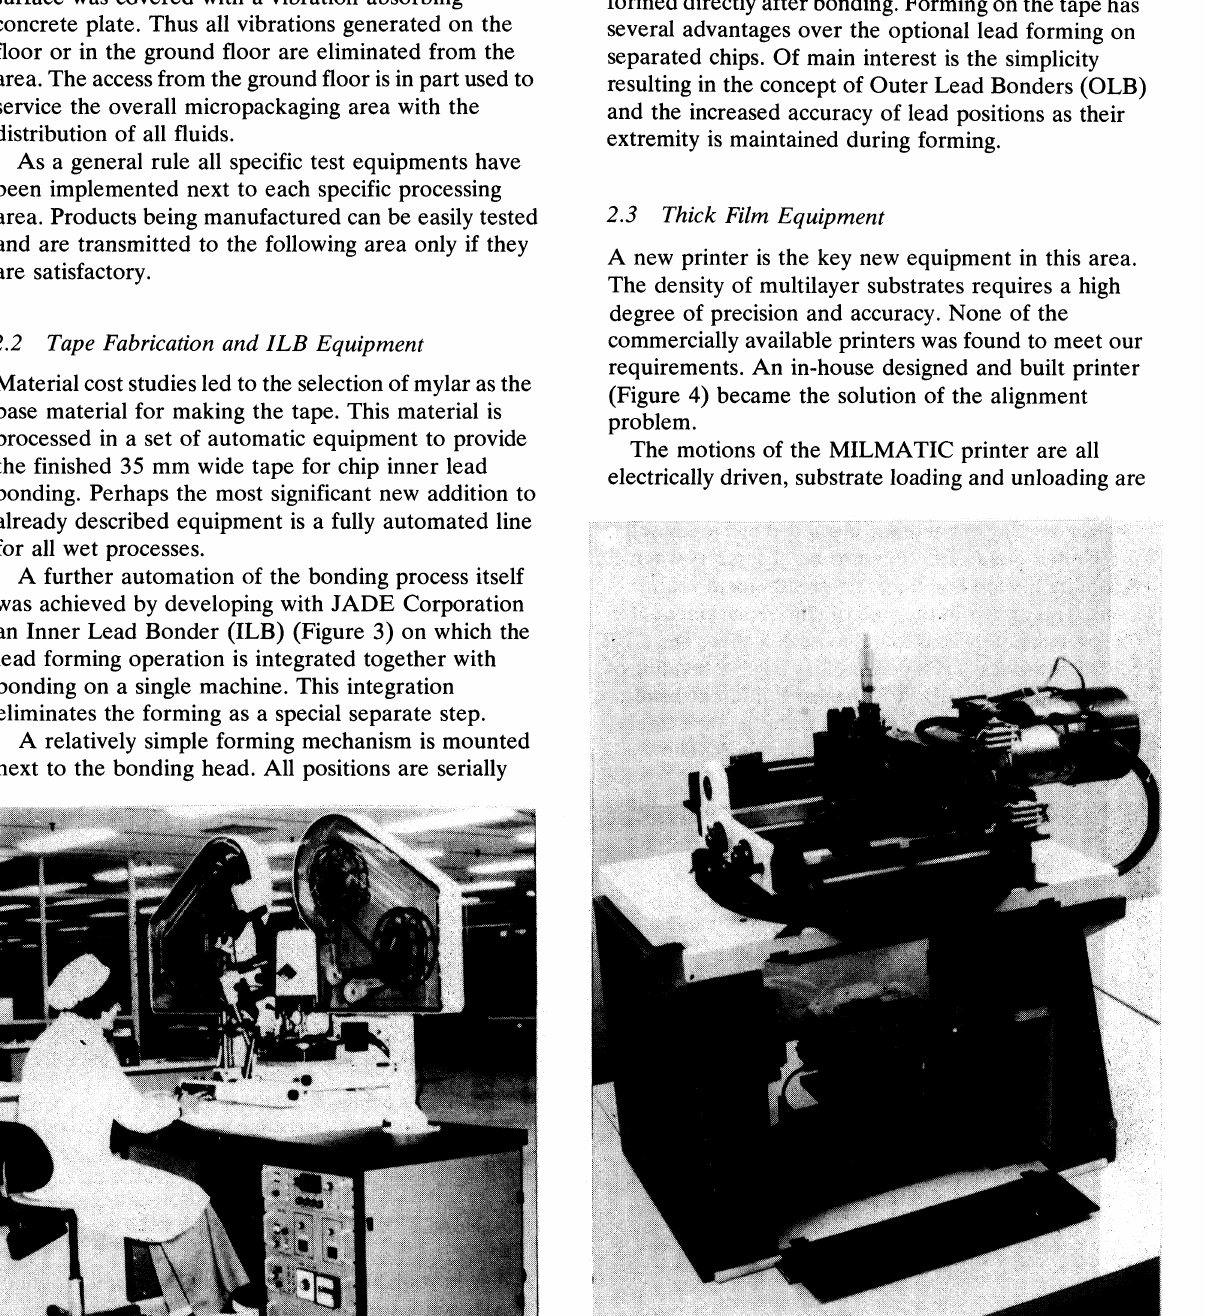
FIGURE 4 MILMATIC high precision thick film printer. The machine designed and built by CII-HB is specially tailored for dense multi-layer